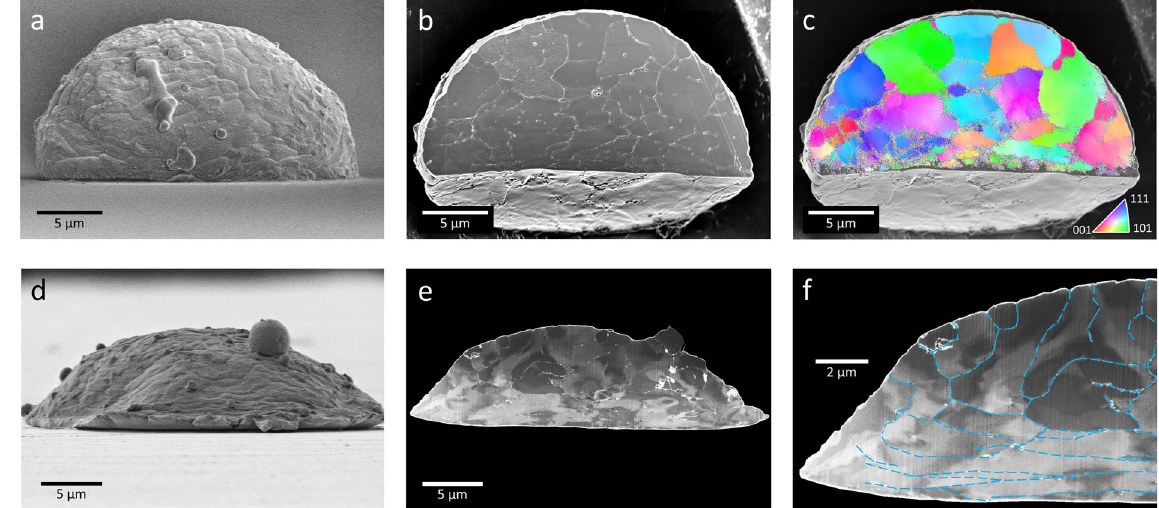
Figure 3. Extreme plastic deformation of the particle after collision to sapphire surface. ( a ) SEM image of the Al-particle deformed by 530 m/s collision to sapphire. ( b ) Contrast-enhanced SEM image after FIB cross section. ( c) EBSD map of the cross sectional plane in the standard stereographic triangle. ( d ) Side-view SEM image of the Al-particle deformed by 660 m/s collision to sapphire. ( e ) Contrast-enhanced SEM image to show ECC. ( f ) A magnified view of the Al-particle with identified GBs in blue dashed lines.